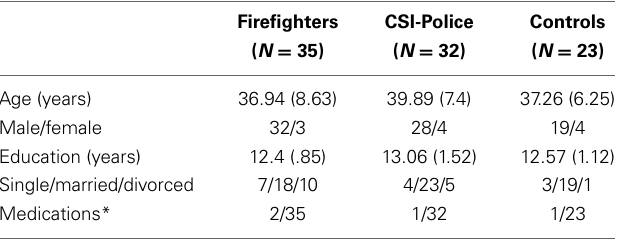
Table 1 | Demographic characteristics of trauma exposed firefighters, CSI police and trauma-unexposed matched